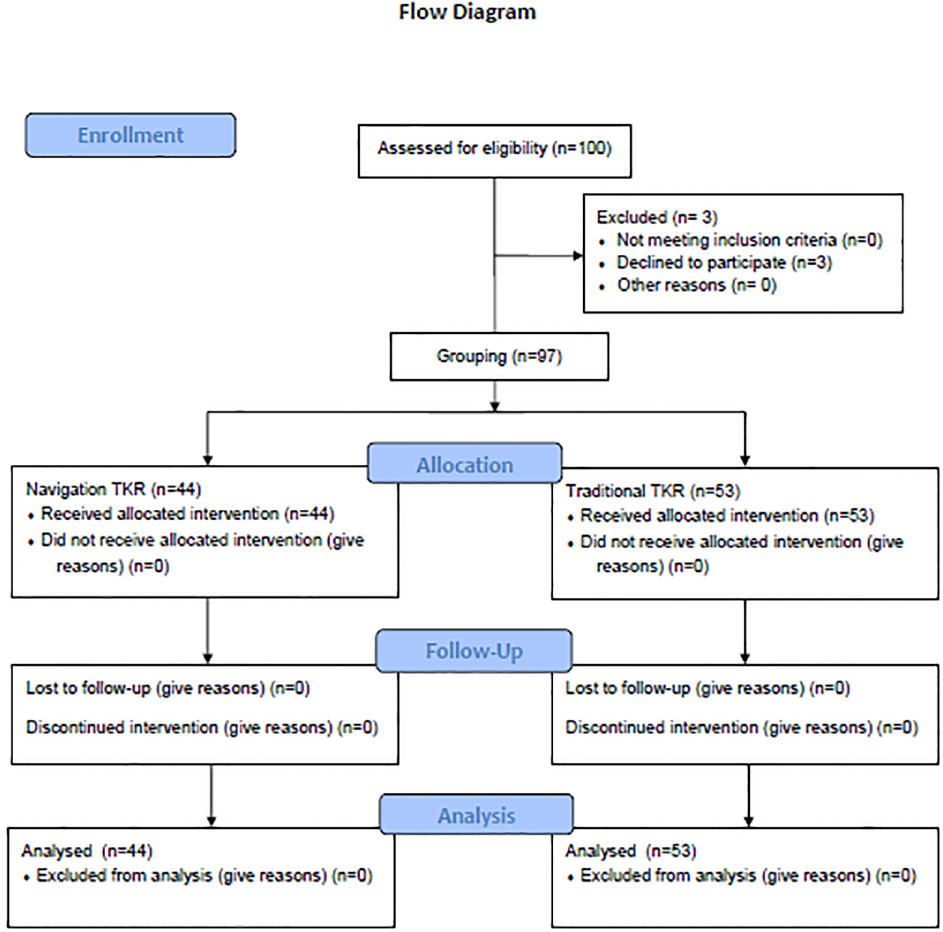
Fig 1. Flowchart of the participants at each stage of the